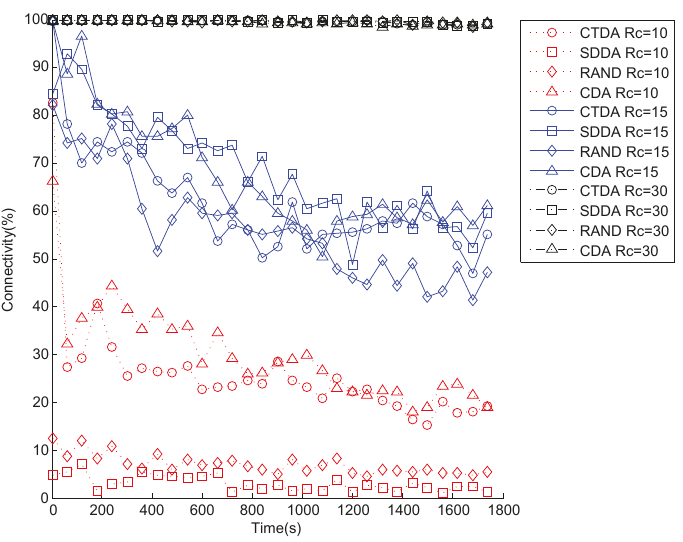
Figure 12. Connectivity varies with time under a dynamic